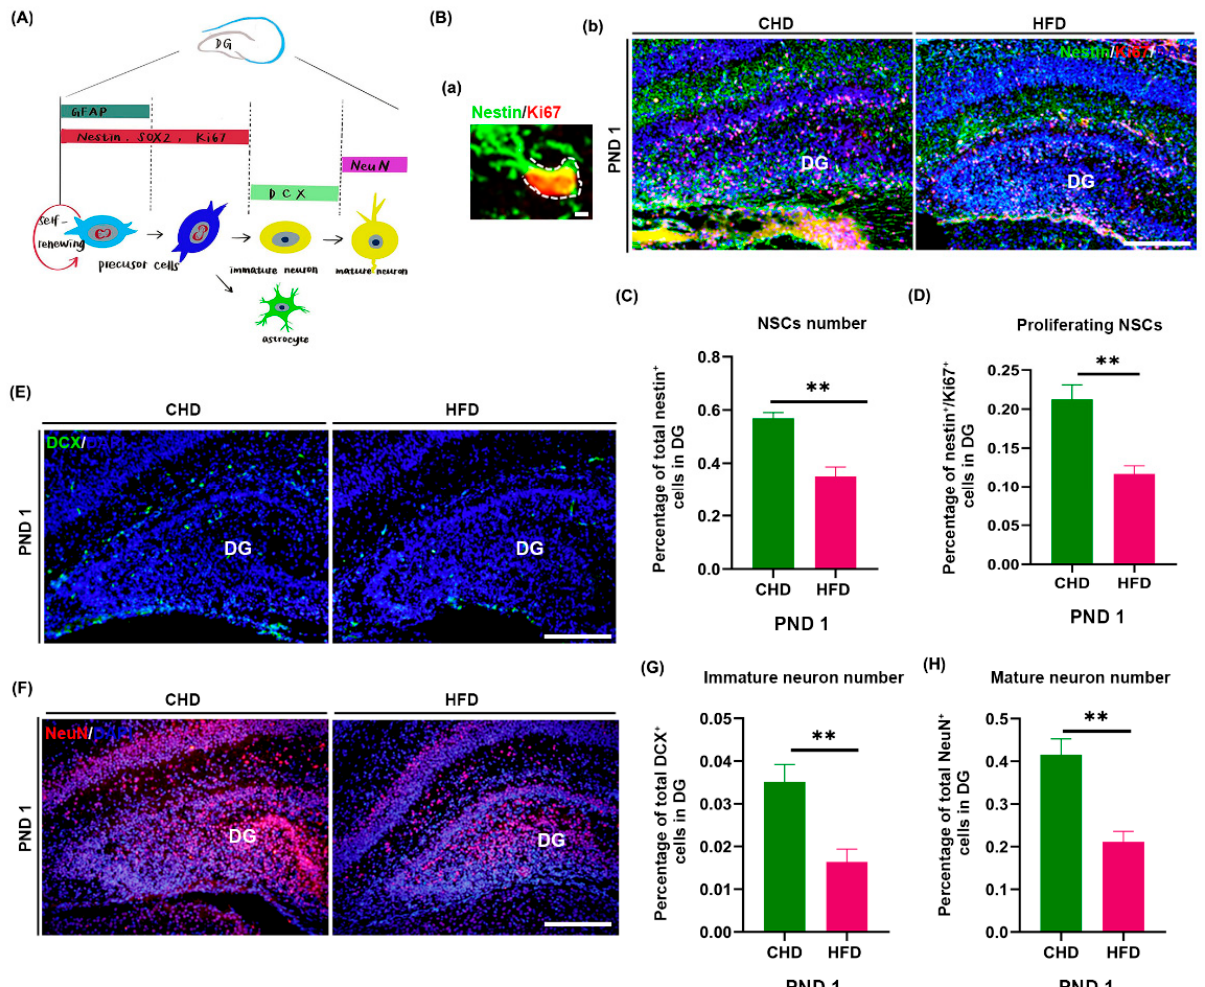
Figure 2. Maternal HFD reduced proliferation and neuronal differentiation of NSCs in offspring DG at birth. ( A ) Overview of neurogenesis originating from a sequence of NSCs in the developmental hippocampus. ( B ) Proliferation of NSCs on PND 1, non-radial NSCs morphology (a), scale bar = 200 µ m; Nestin (green)/Ki67 (red) immunostaining (b), scale bar = 50 μ m. ( C ) Quantification of NSCs number ( n = 4). ( D ) Quantification of proliferating NSCs number ( n = 5). ( E ) DCX (green) immunostaining, scale bar = 50 μ m. ( F ) NeuN (red) immunostaining, scale bar = 50 μ m ( n = 4). ( G ) Quantification of immature neurons number ( n = 4). ( H ) Quantification of mature neurons number ( n = 4). ** p < 0.01 vs. CHD. DG, dentate gyrus; NSCs, neural stem cells; DCX, doublecortin; PND, postnatal day.